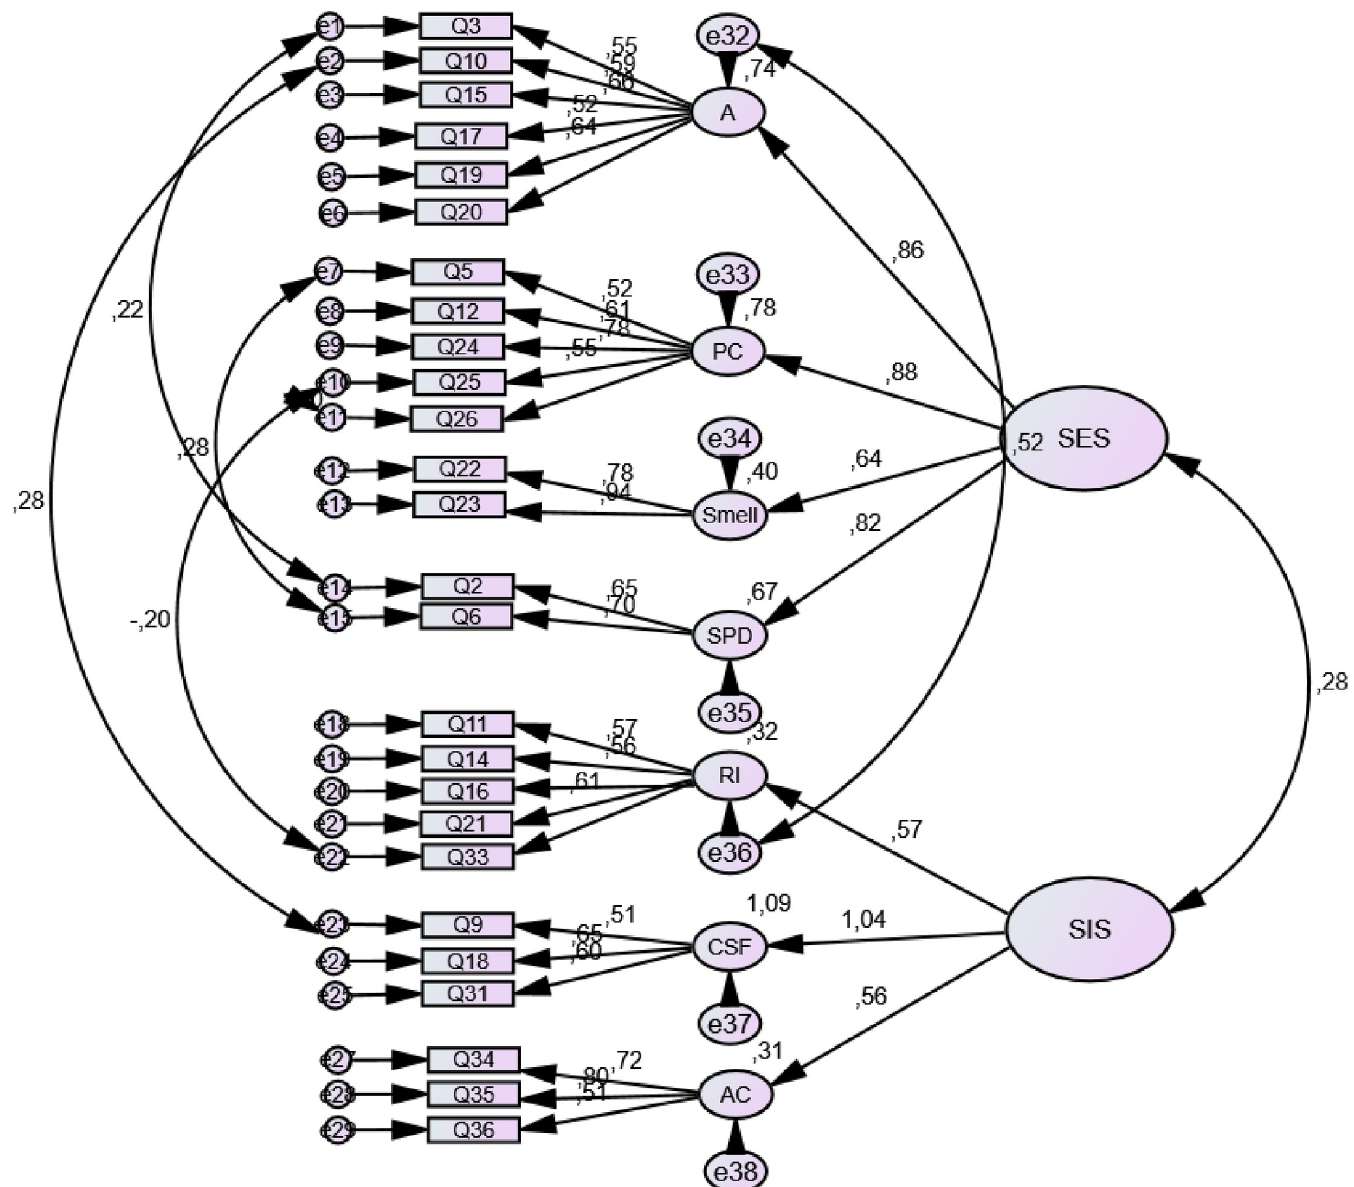
Fig 2. Final model of the